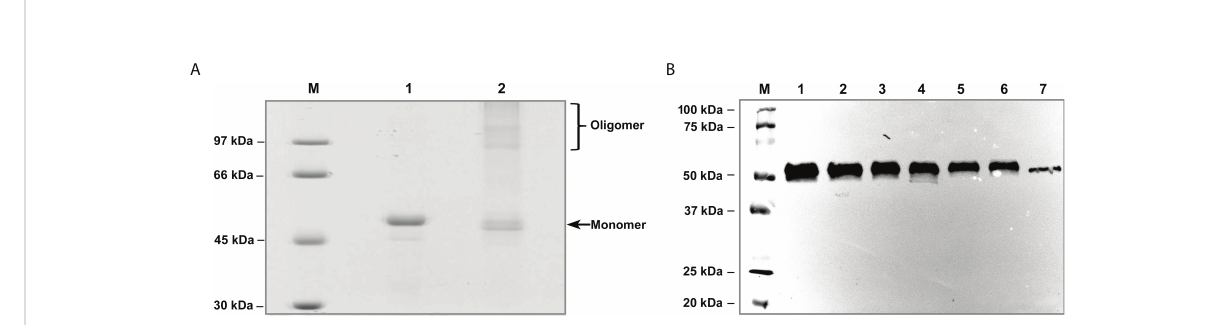
FIGURE 4 Puri fi cation of recombinant L. interrogans leptolysin and detection of the native protease in Leptospira culture supernatants. (A) Puri fi ed recombinant leptolysin was analysed under reducing (1) and nonreducing (2) conditions. Proteins were separated by SDS/12% PAGE and stained with Coomassie Brilliant Blue. M: molecular mass marker. (B) Production of leptolysin by (1) Leptospira interrogans serovar Copenhageni strain Fiocruz L1-130, (2) Leptospira interrogans serovar Kennewicki strain Fromm, (3) Leptospira interrogans serovar Copenhageni strain 10A, (4) Leptospira kirschneri serovar Cynopteri strain 3522C, and the saprophytes (5) Leptospira bi fl exa serovar Andamana strain CH11 and (6) Leptospira bi fl exa serovar Patoc strain Patoc I; (7) Recombinant leptolysin. Proteins from Leptospira supernatants were separated by SDS/12% PAGE, transferred to nitrocellulose membranes, and probed with leptolysin antiserum produced in